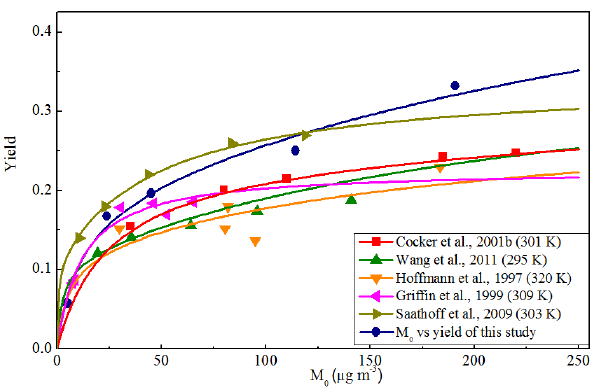
Fig. 7. Comparison of yield data obtained for α -pinene ozonolysis experiments in GIG-CAS chamber with other chamber facilities. All experiments are carried out under dry condition. Blue line is the best fit two-product model for the data set of